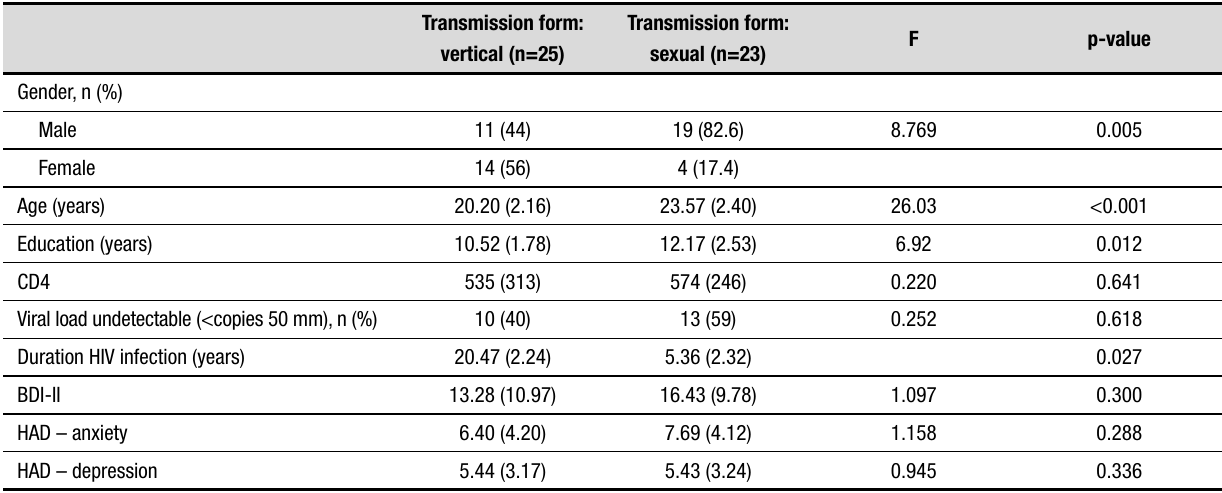
Table 1. Sociodemographic and clinical data.